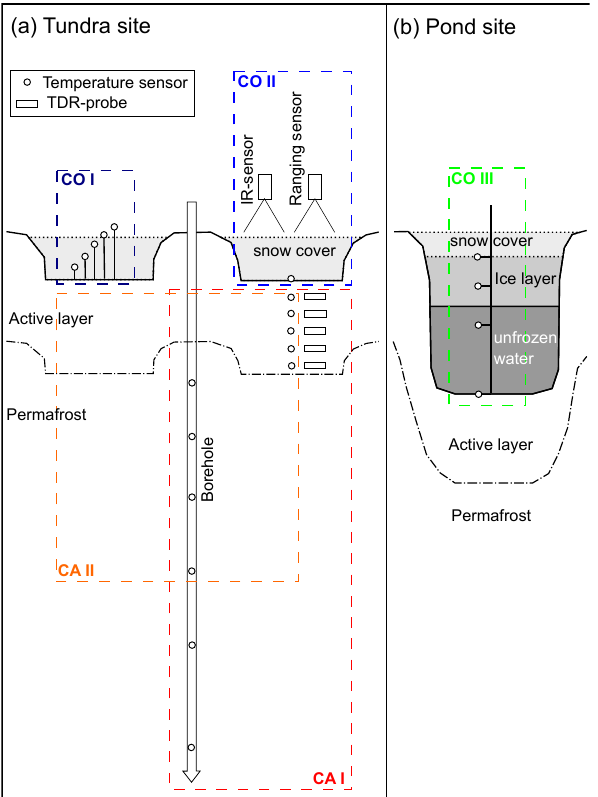
Fig. 2. Scheme of the different measurement setups used for the evaluation of ground heat flux. (a) Cross-section of the tundra soil indicating polygonal rims and centers. (b) Cross-section of the polygonal pond during the stage of freezing. Note that the depicted scheme is not to scale.